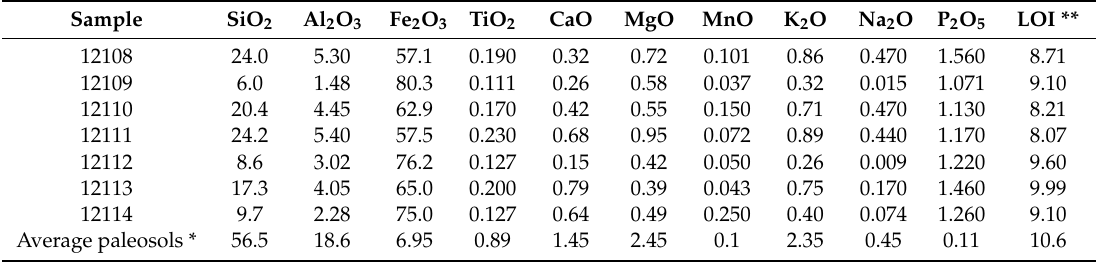
Table 3. Major element compositions (wt. %) of pisolith samples (recalculated on a volatile-free basis).